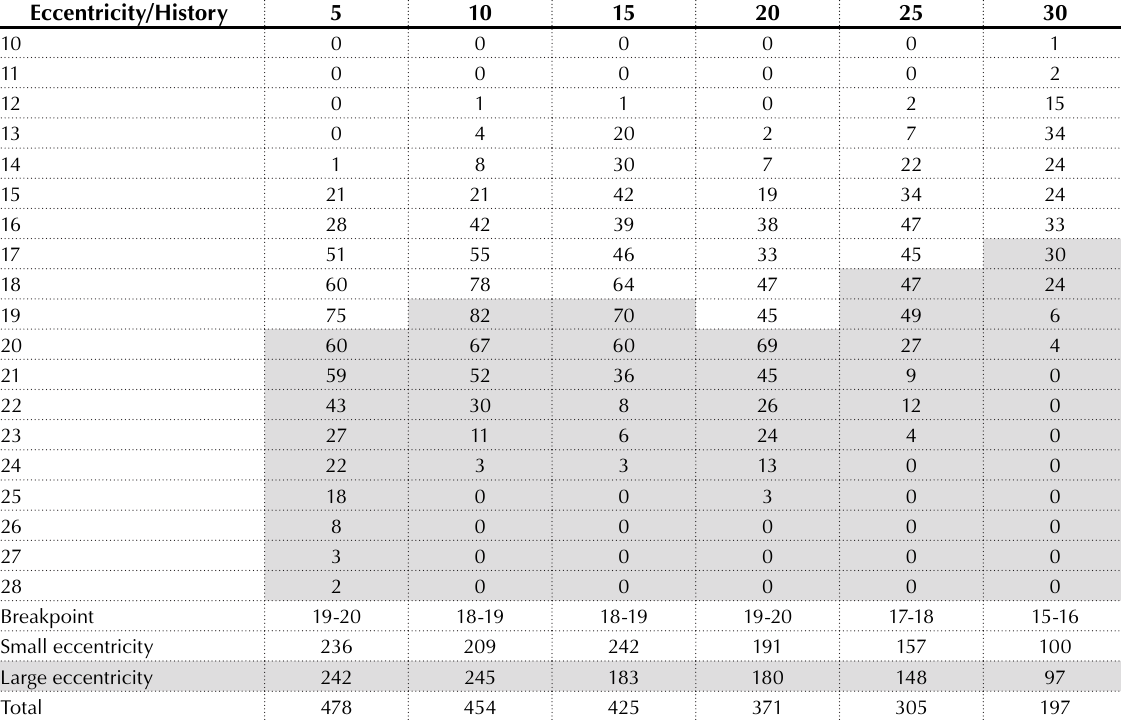
Table 2. Process of division into large and small eccentricity for individual time histories